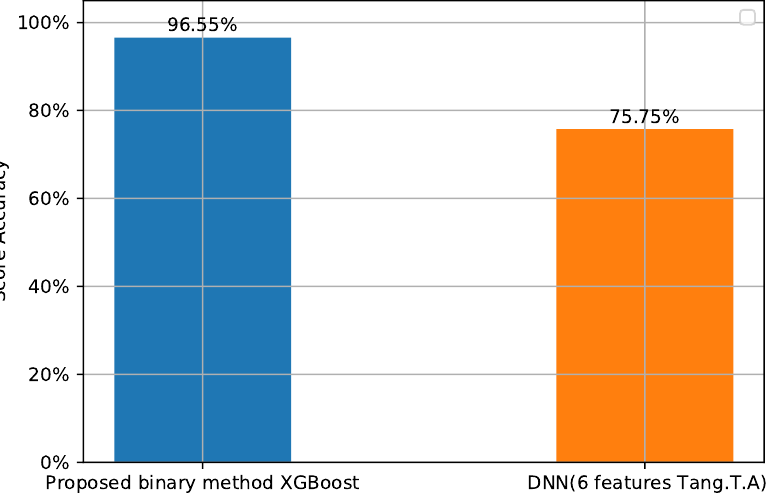
Figure 9. Attack detection rate comparison between the proposed XGboost method and